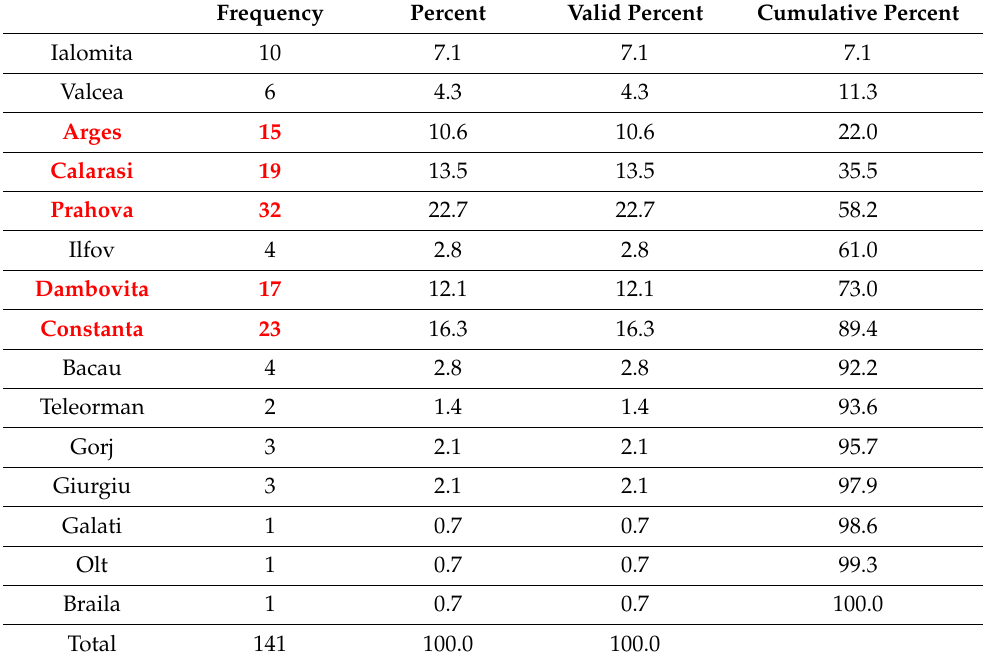
Table 9. Recorded incidents by county.